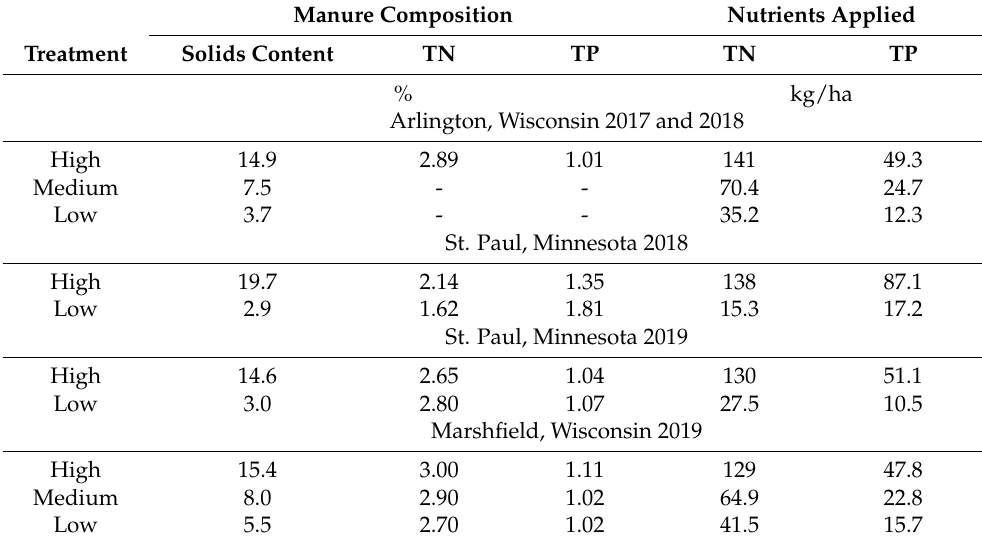
Table 1. Manure composition and estimated total nitrogen and phosphorus applied.